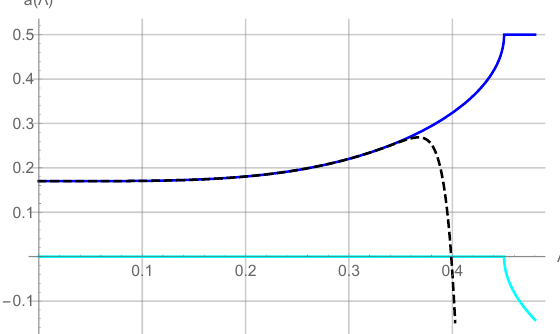
Figure 3. The black dashed line is the a cycle derived with the recursion relation until ten instantons for p = 0 . 17 , the blue (cyan) line is the real (imaginary) part of the A-cycle derived with